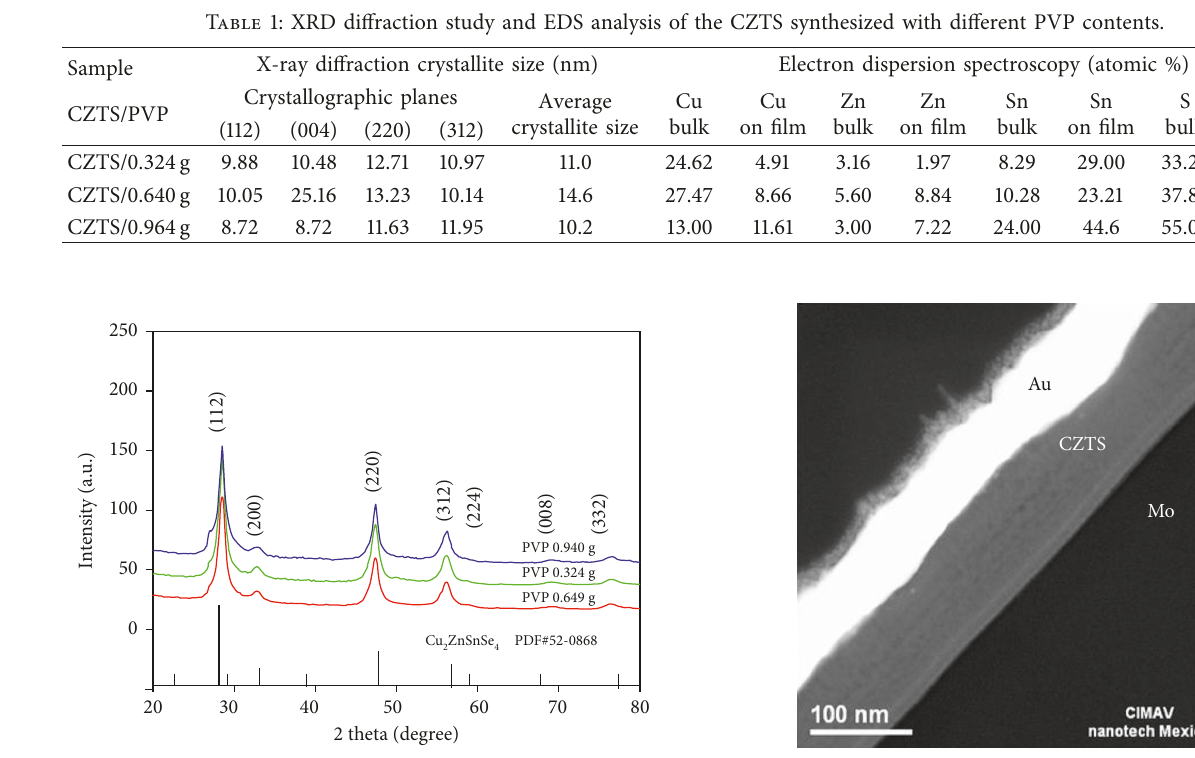
Figure 7: HRTEM image of the cross section of an assembly of CZTS and Mo. The image shows the advantages of the physical vapor deposition process on producing extremely homogeneous thin